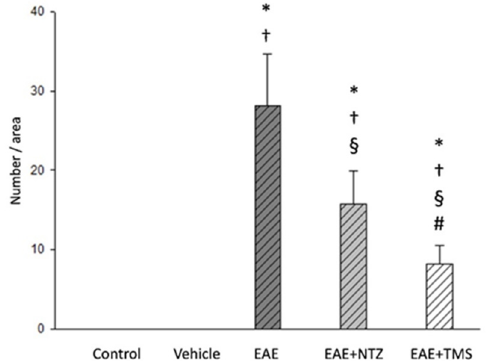
Figure 5. Number of muscle fibers per area with cytoarchitectural lesions in EDL muscle fibers at day 36. Values are means ±SD. There were no lesions detected in control and vehicle groups. * Significantly different (s.d.) from control group; † s.d. from vehicle group; § s.d. from EAE group; # s.d. from EAE + NTZ ( n = 7 per group).